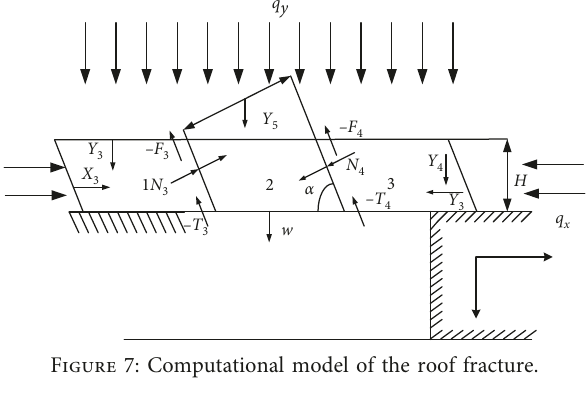
Figure 7: Computational model of the roof fracture.